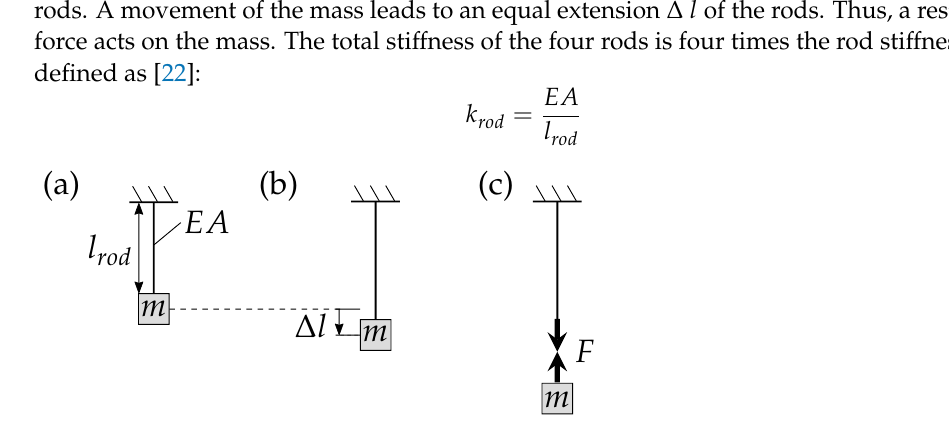
Figure 10. A massless rod of an extensional stiffness EA that is provided with a mass m at its end ( a ) is extended by ∆ owing to a movement of the mass ( b ). A restoring force acts on the mass ( c ). The sketches are based on